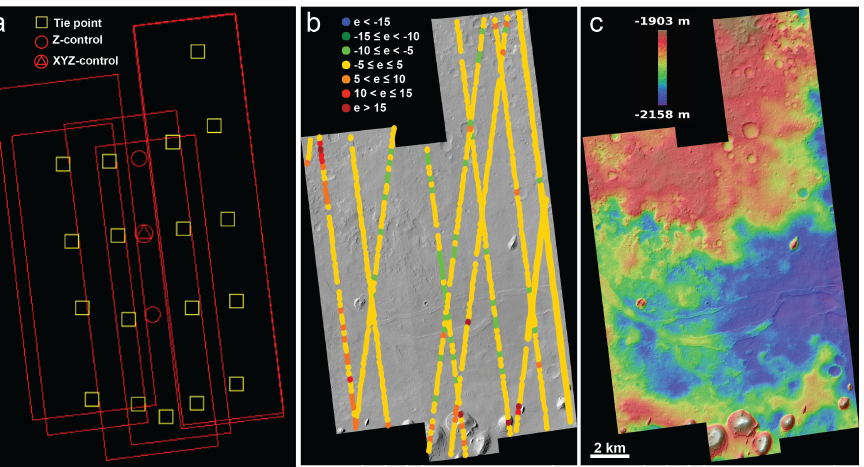
Figure 9. HiRISE DTM mosaic made from three adjacent, overlapping HiRISE stereo pairs (ESP_037162_1880 and ESP_036384_1880, ESP_036740_1880 and ESP_037030_1880, ESP_035962_1880 and ESP_036529_1880). ( a ) Image footprints overlaid with symbols indicating locations of tie and control points used in SOCET Set MST. ( b ) Shaded relief image with autoTriangulation error map showing comparison to MOLA. Error “e” is elevation difference from MOLA in meters. The mean elevation difference is − 0.71 m, with a standard deviation 4.34 m. ( c ) Colorized shaded relief image illustrating the continuity of elevation values across seams. Tie points in overlapping regions allowed images to be controlled relatively to within the vertical precision of each DTM, resulting in differences at DTM seams of <1